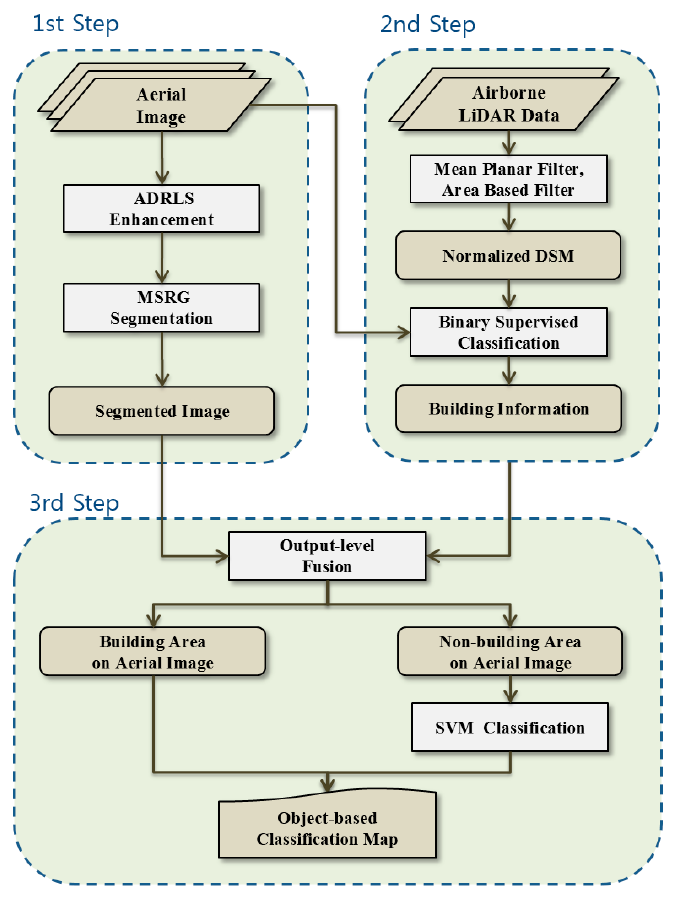
Figure 1. Flowchart of classification generation using the new method.